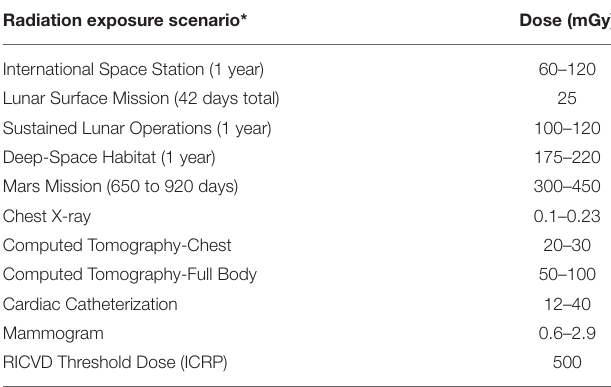
TABLE 1 | Dose estimates for radiation exposures on earth and in space (2, 11,